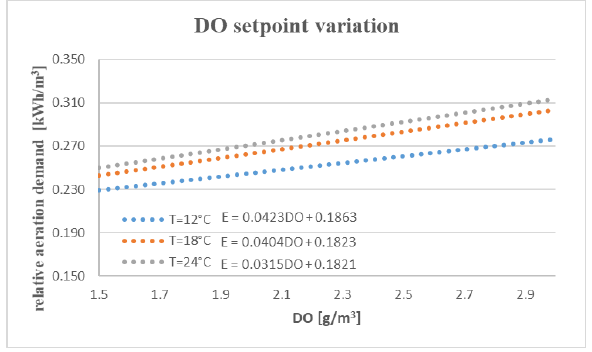
Figure 4. Relative aeration demands at various DO setpoints.